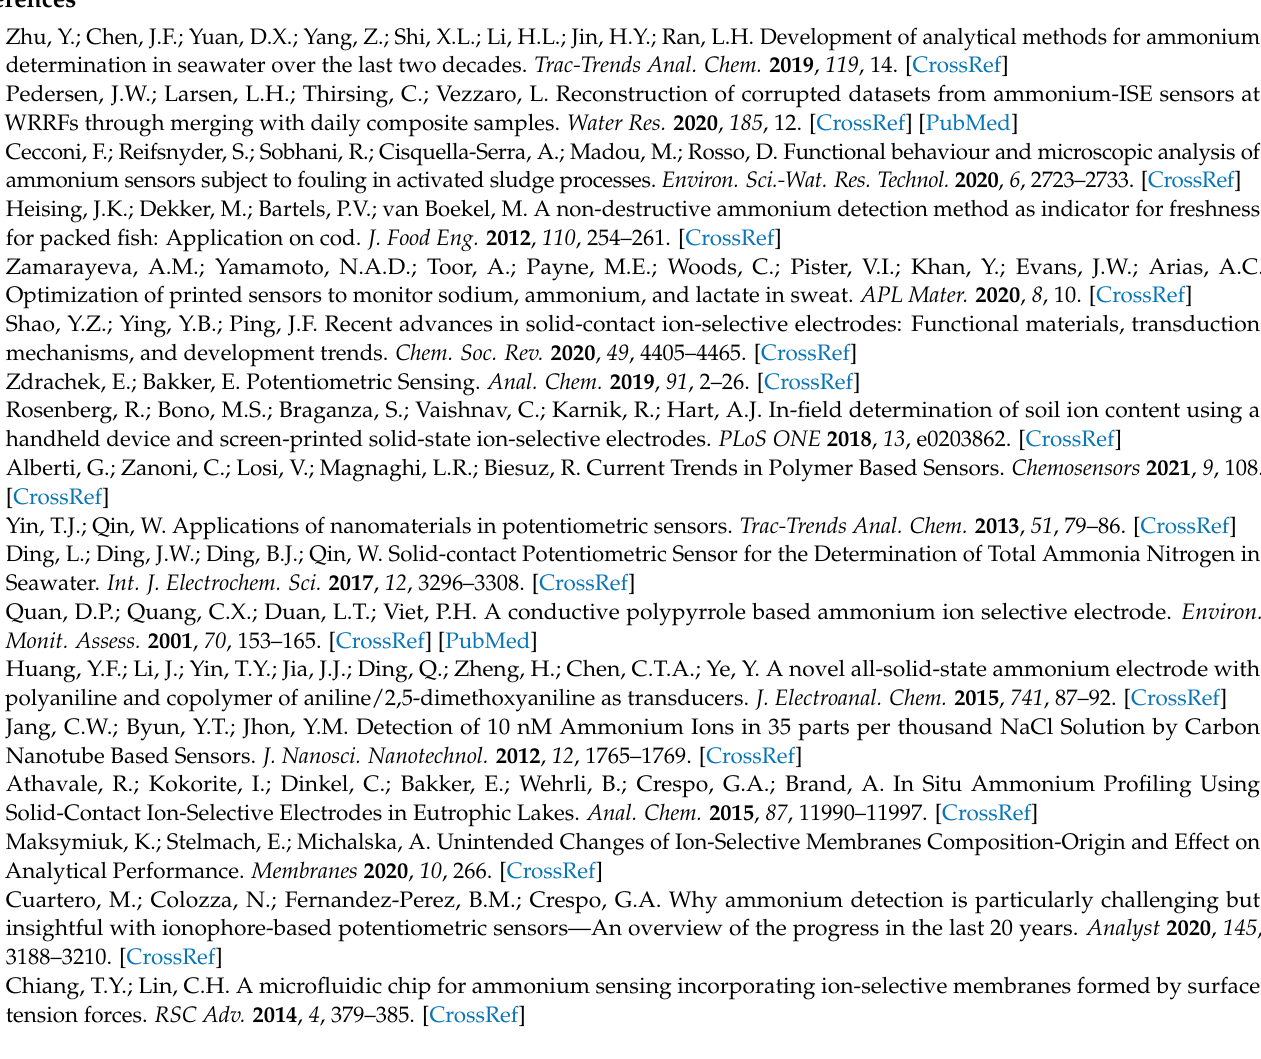
Figure S3: Optimization of the sensor parameters. Linear range of ammonium-selective ISE prepared with various amounts of graphite—PVB (50 wt %) transducer formulation layered over a graphite disc electrode and different volumes of membrane mixture. The measurements were performed in the same solutions as in the previous Figure; Figure S4: R(Q(RW)) circuit for simulation of impedance spectra (a) and results of circuit modeling (b) of graphite (65 wt %)—PVB coated graphite electrode using ZSimpWin simulation programme. Rs—solution resistance, Rct—charge transfer resistance, ZW—Warburg impedance, Q—constant phase